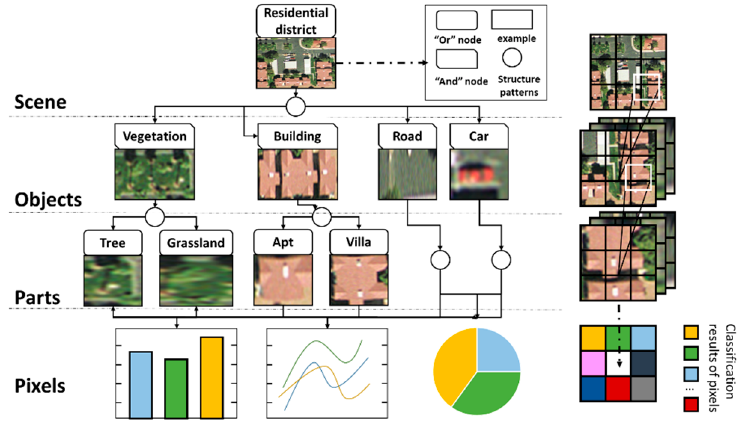
Figure 9. Hierarchical representation structure of the semantic of geographic scene.